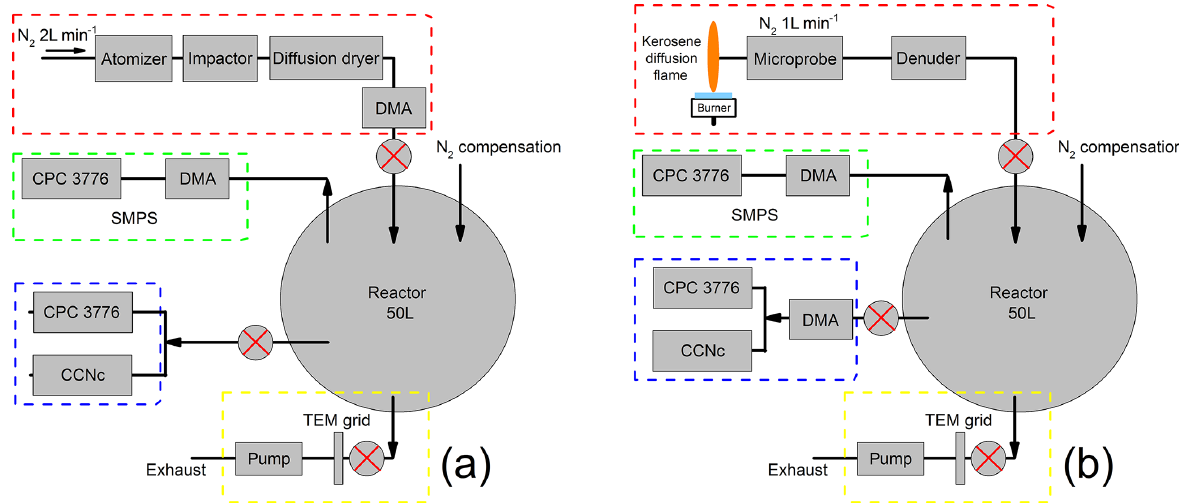
Figure 2. Overview of the experimental setup used for (a) ammonium sulfate and (b) soot. Aerosol injection system (red frame), size distribution measurement system (green frame), activated fraction measurements system (blue frame) and collection system for TEM grids (yellow